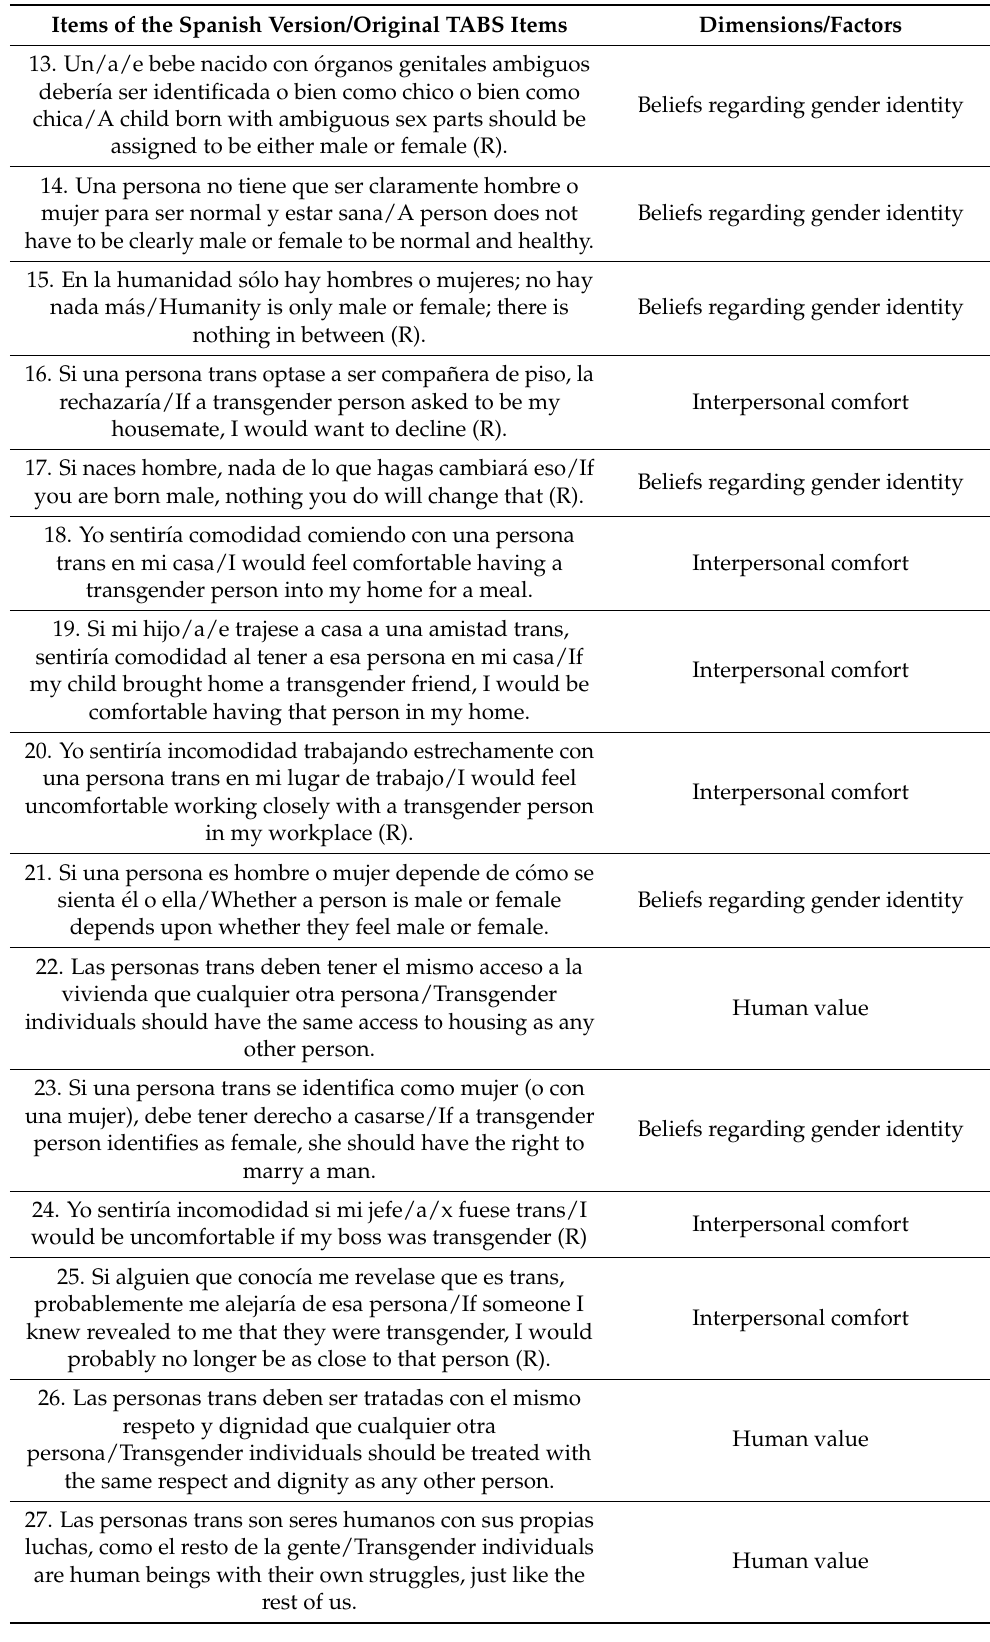
Table A1. Cont. Items of the Spanish Version/Original TABS